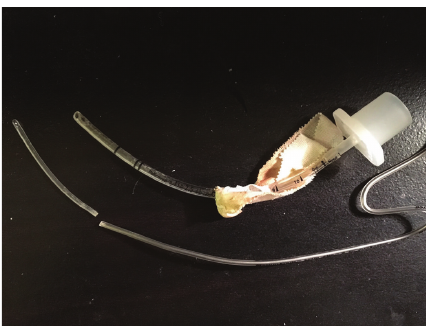
Figure 1: The sheared off piece of plastic and the stylet alongside the endotracheal tube.